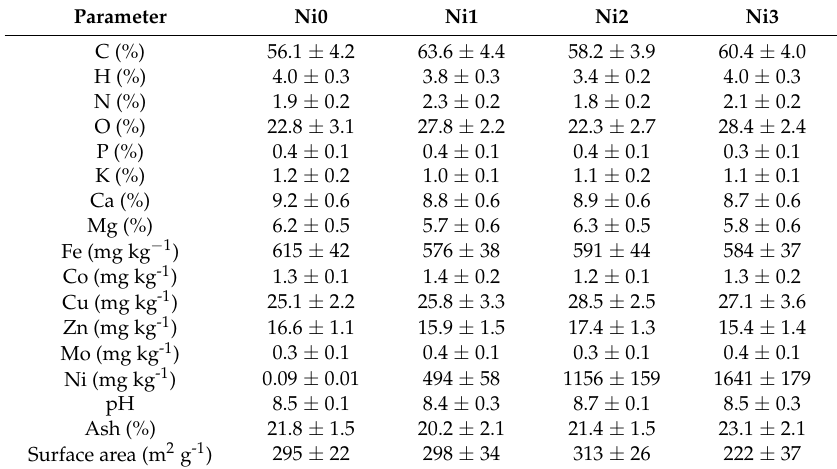
Ni contents (see Table 2).